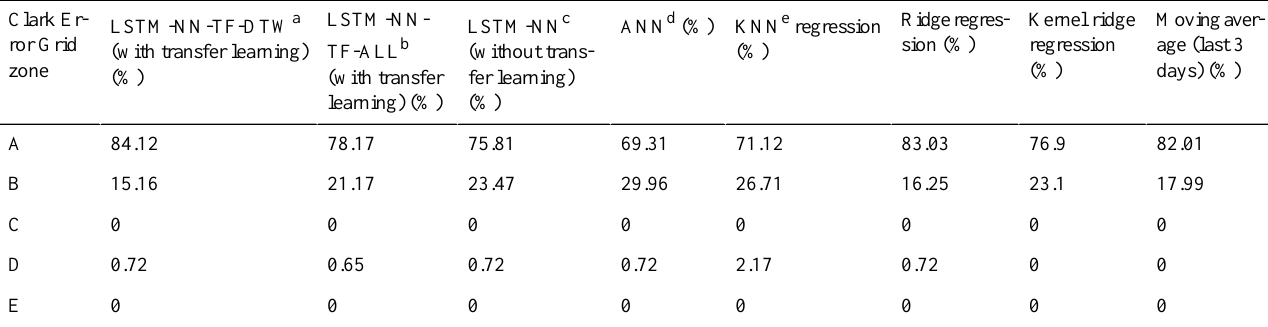
Table 2. Percentage of prediction points on the Clark Error Grid